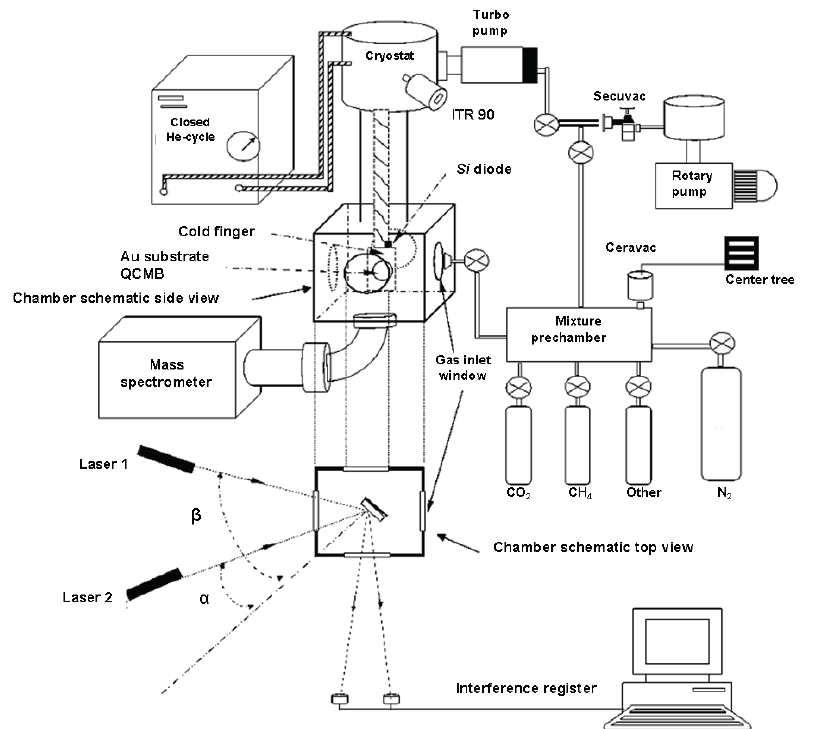
Figure 5. Setup of the experimental